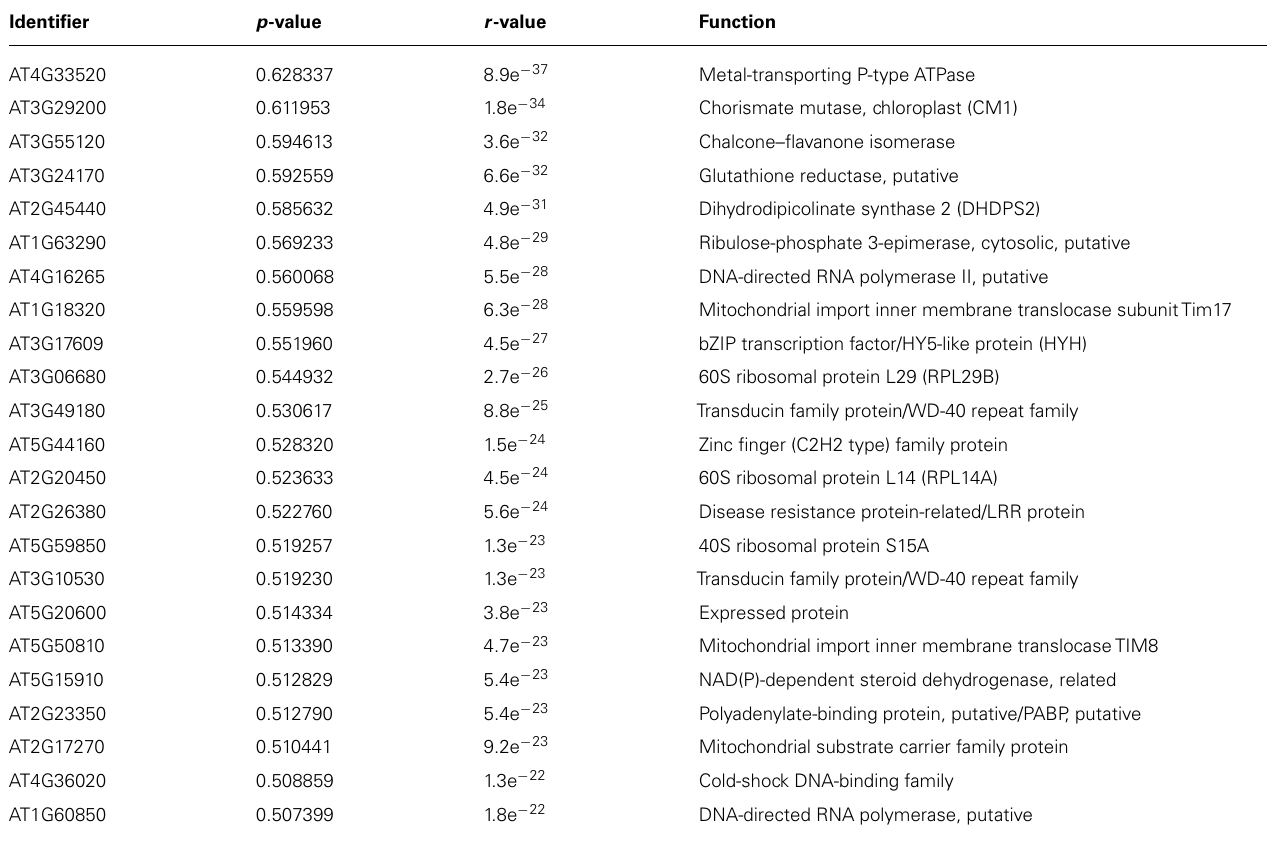
Table 2 | Bioinformatic identification of genes that carry theATGCACGTC motif in their promoter and co-expressed with sAPX